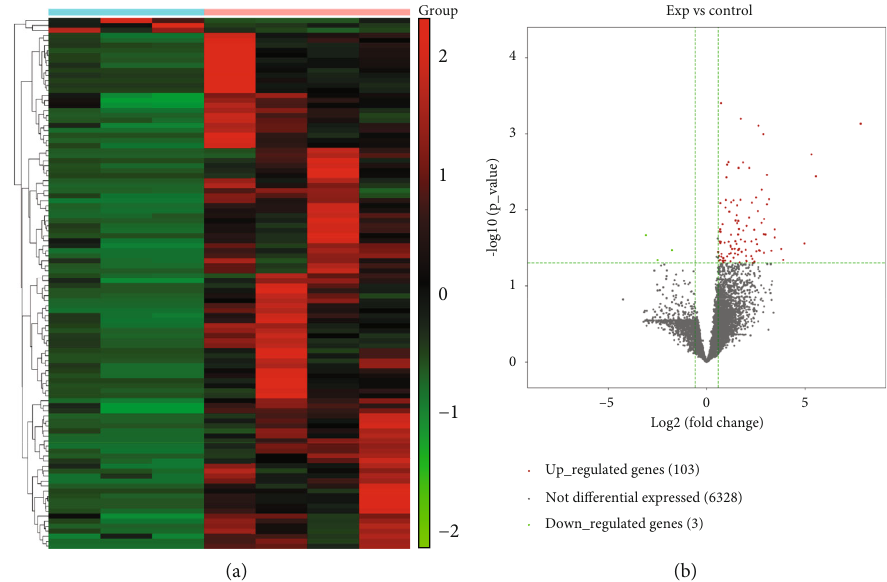
Figure 2: Heat map and volcano plot of di ff erentially expressed long noncoding RNAs (DE-lncRNAs) from urinary exosomes. (a) Heat map of all DE-lncRNAs from urinary exosomes of healthy controls and bladder urothelial carcinoma (BLCA) patients. Results of the di ff erential analysis are shown ( P ≤ 0 : 05 ), with color from green to red indicating low to high fragments per kilobase of exon per million mapped fragments (FPKM) of DE-lncRNAs. (b) Volcano plot of RNA-sequencing results. Green dots represent downregulated genes and red dots represent upregulated